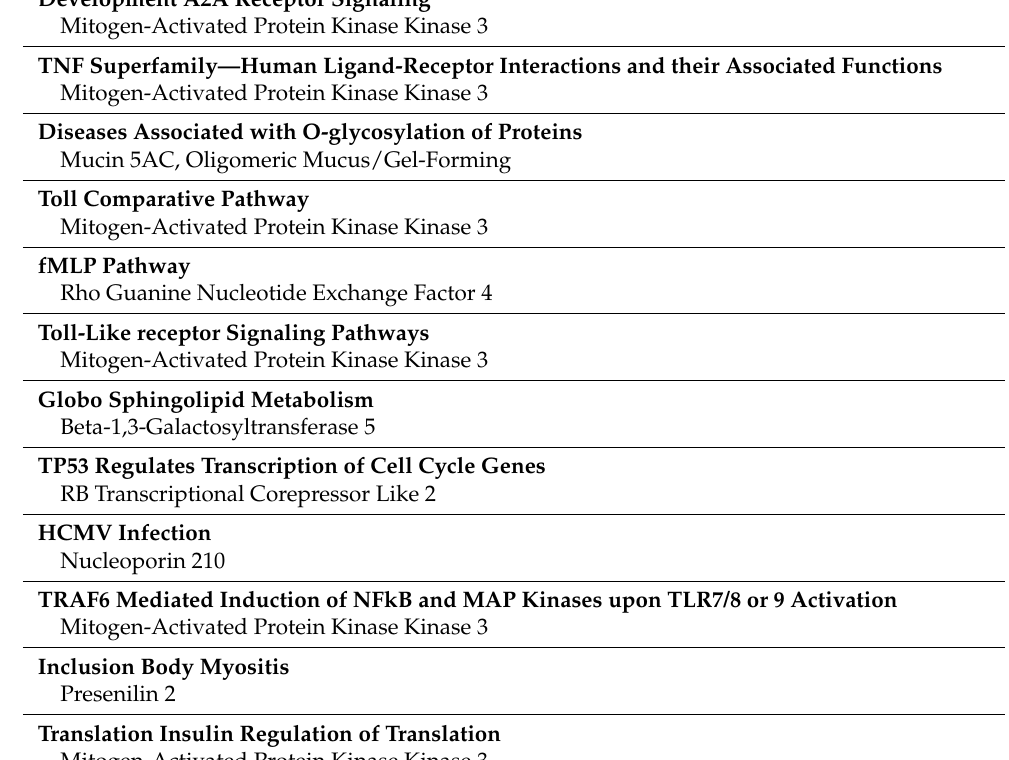
Table A2. Cont. Development A2A Receptor Signaling Mitogen-Activated Protein Kinase Kinase 3 TNF Superfamily—Human Ligand-Receptor Interactions and their Associated Functions Mitogen-Activated Protein Kinase Kinase 3 Diseases Associated with O-glycosylation of Proteins Mucin 5AC, Oligomeric Mucus/Gel-Forming Toll Comparative